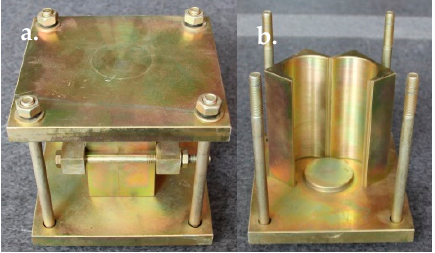
Figure 1. Device for the cemented rockfill specimen production. Closed state ( a ); and, Open state ( b ).